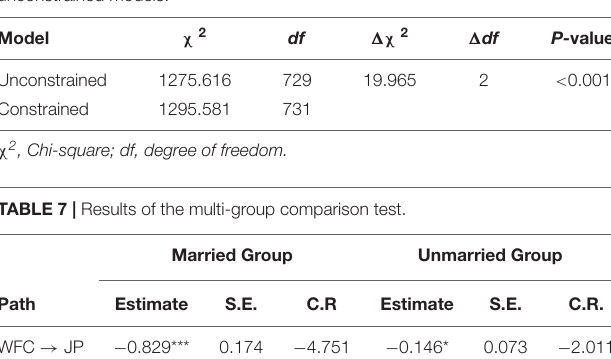
TABLE 6 | Chi-square value and degree of freedom for the constrained and unconstrained models.